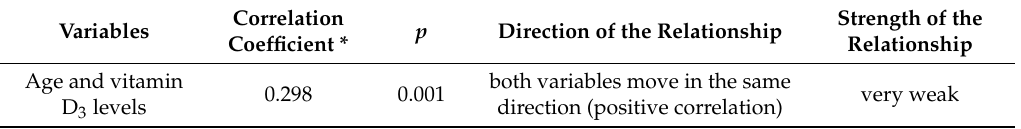
Strength of the Relationship very weak